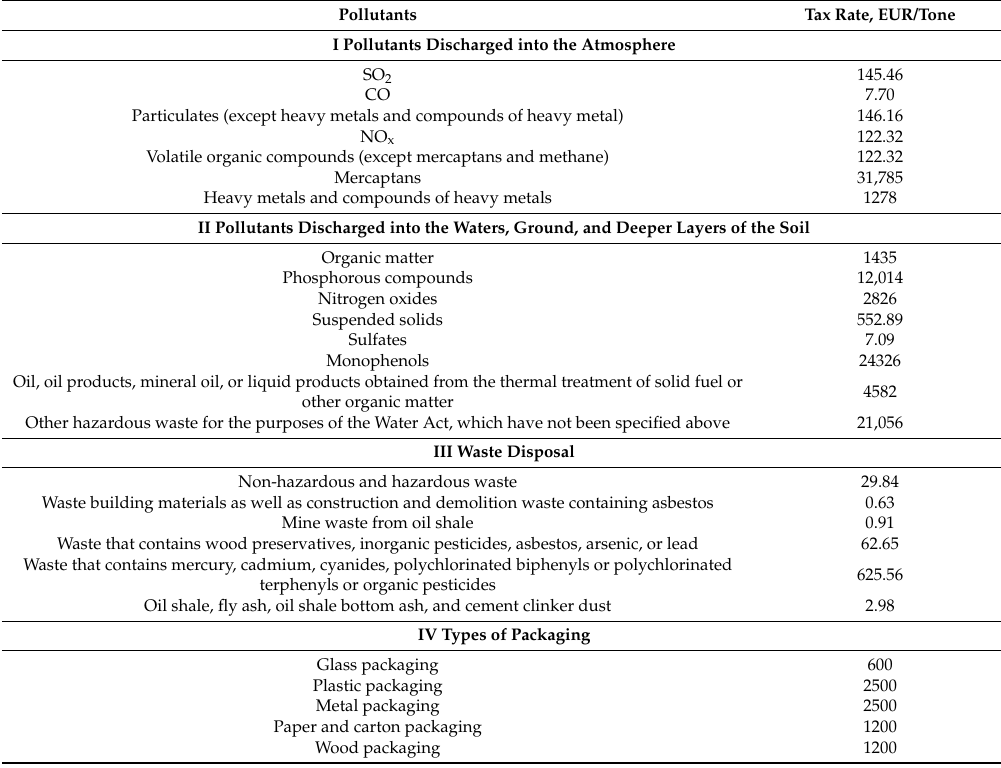
Table 2. The tax rates for pollutants in Estonia, 2015